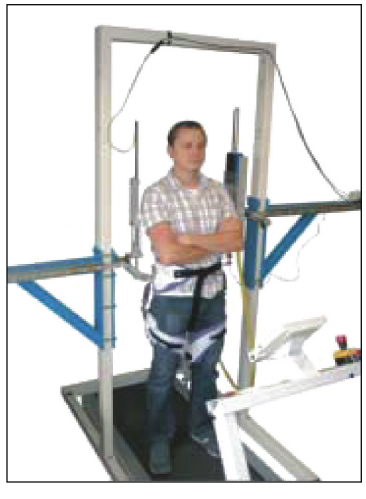
Figure 8: RGR Trainer.